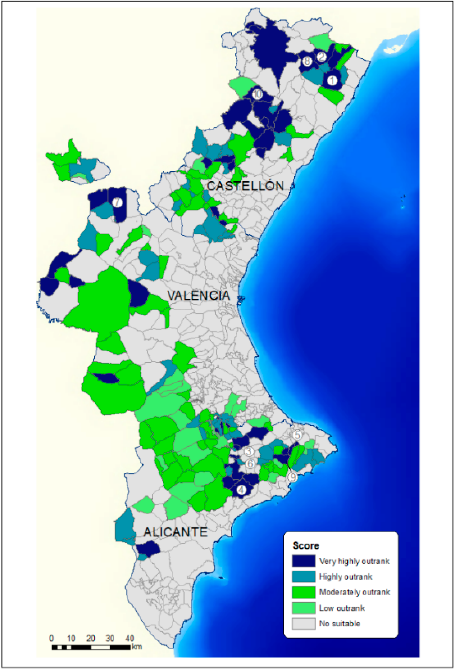
Table 8. Classification criterion for evaluating municipalities with land suitable for the swine sector development.